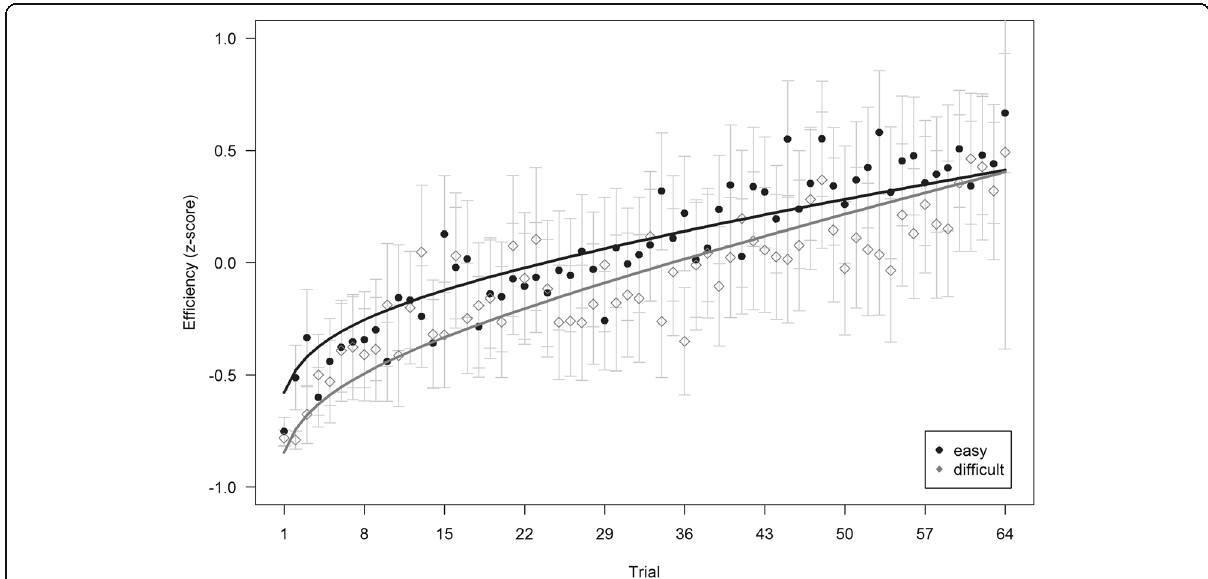
Fig. 4 Changes in performance in primary task efficiency over the task. Filled dots and empty rhombi show empirical mean values per trial, lines indicate predicted mean values. Error bars indicate 95% confidence intervals from empirical